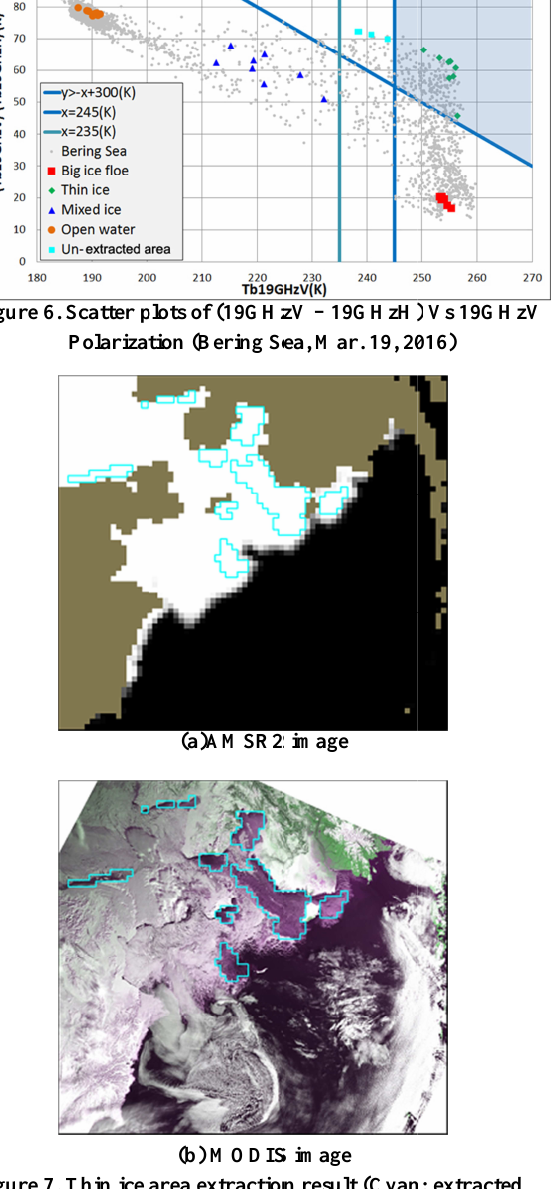
Figure 7 . Thin ice area extraction result (Cyan: